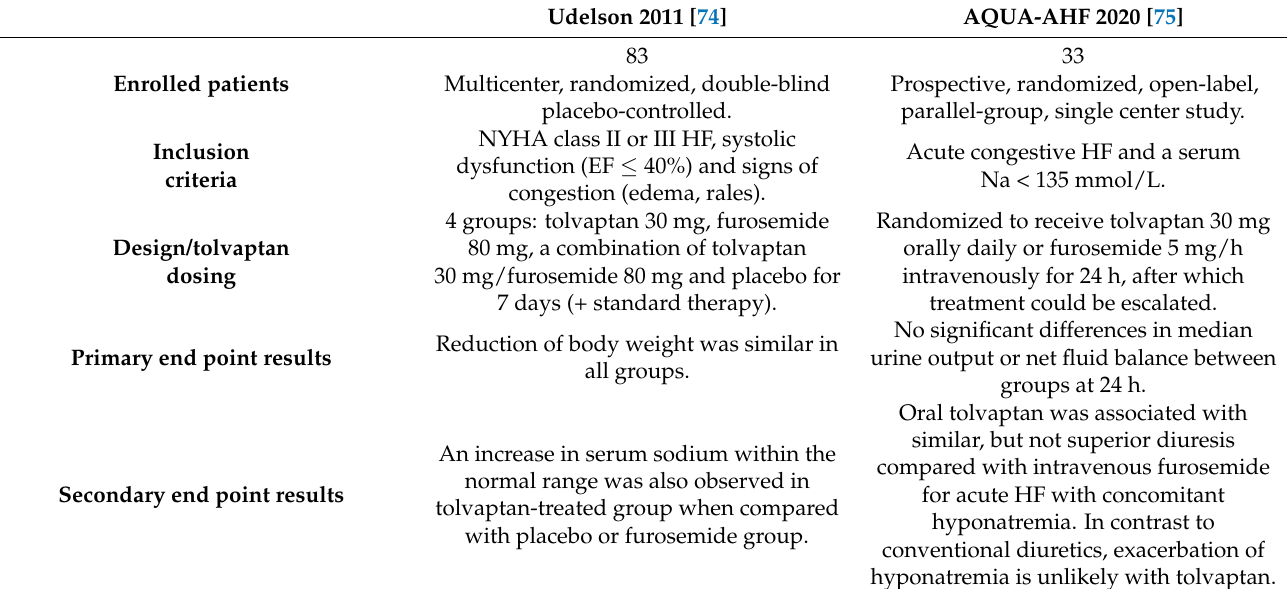
Table 3. Tolvaptan as an alternative therapy to loop diuretics in chronic and acute failure with hyponatremia